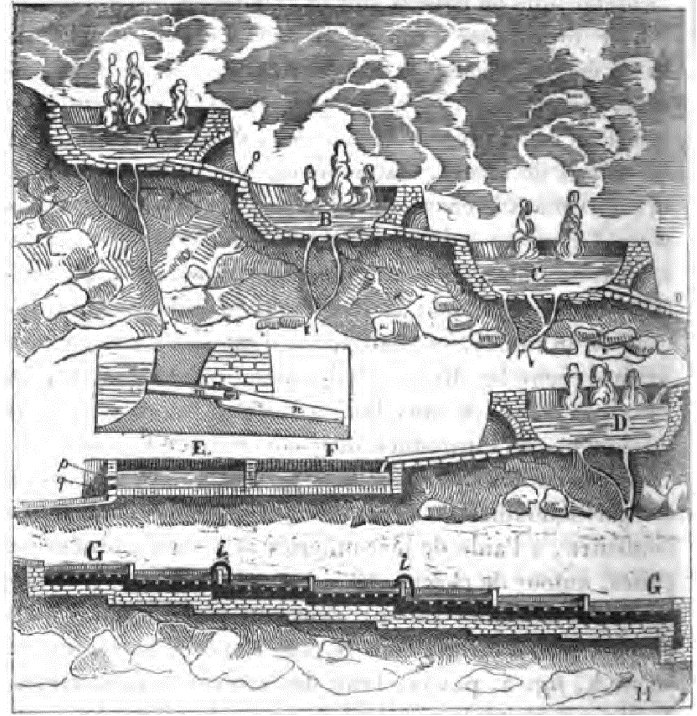
Figure 5. The first ‘lagoni’ (natural lakes and ponds) were limited and connected to allow brines to be collected for further